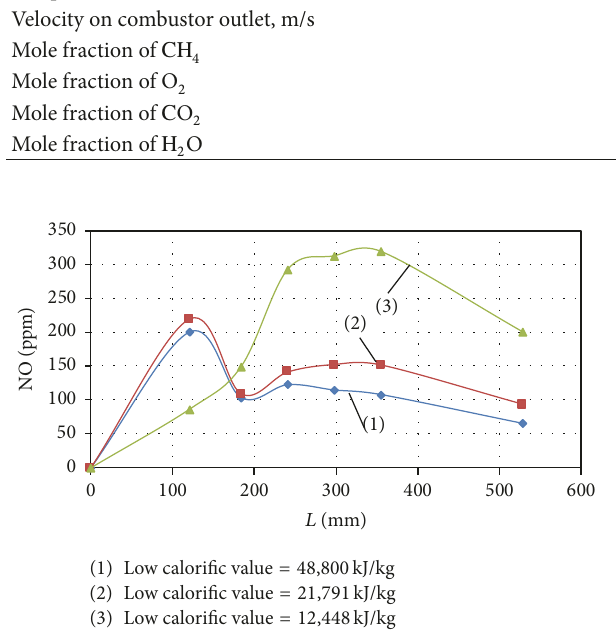
Figure 10: Distribution of NO volume fractions in the longitudinal sections of the